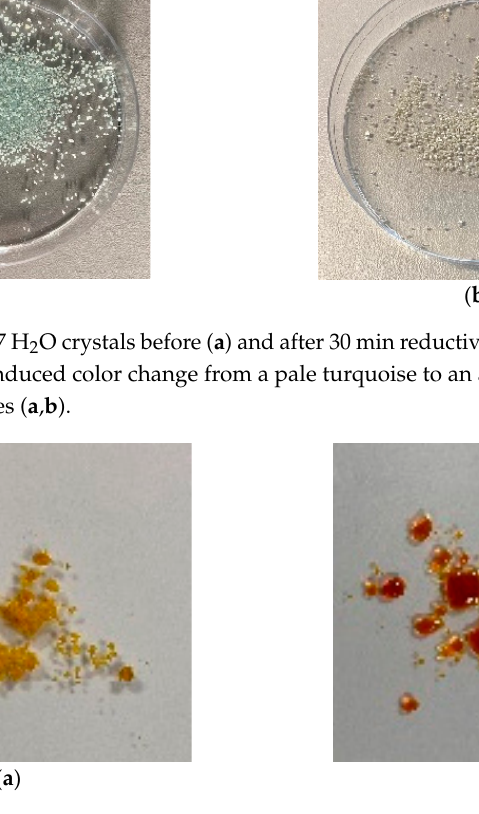
( b ) Figure 10. Microscope images of CuCl 2 crystals before ( a ) and after the one-hour Varigon plasma treatment at a low pressure ( b ). Picture ( b ) shows the plasma-induced color change as an indicator of a surface alteration caused by plasma reduction processes. ( a ) ( b ) Figure 11. Microscope images of FeSO 4 crystals before ( a ) and after the one-hour Varigon plasma treatment at low pressure ( b ). The comparison of the two pictures shows a clear discoloration, which indicates a Varigon plasma-induced change in the chemical composition of the surface.